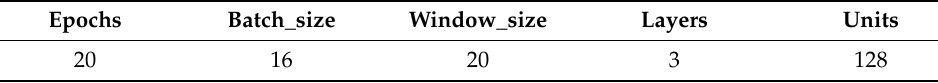
Table 3. GRU-DeepAR model